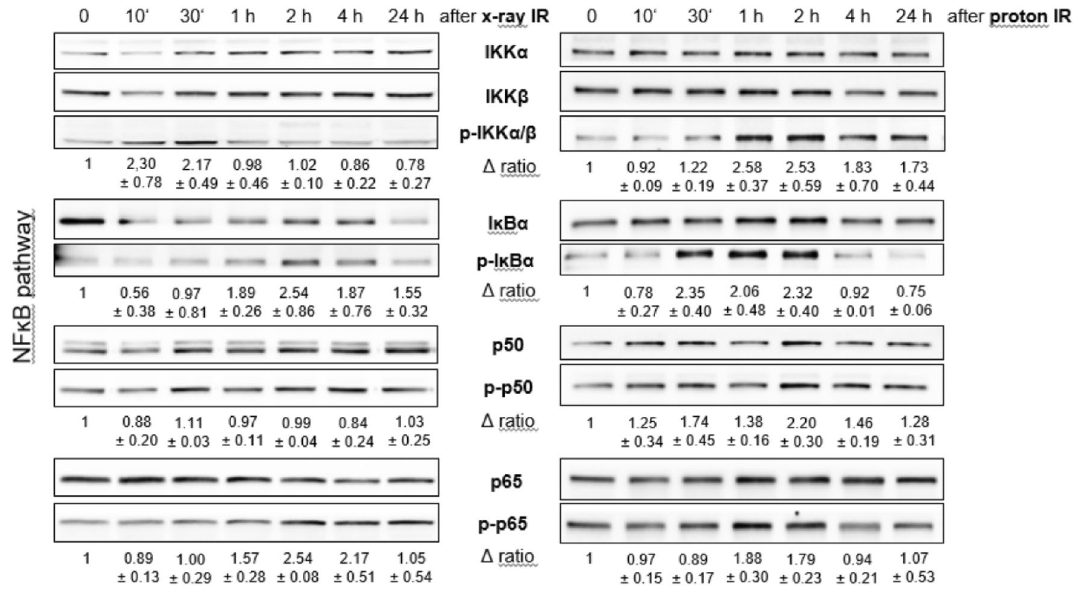
Figure 6. NF-ĸB damage pathway. Protein expression and phosphorylation of components of the NF-ĸB pathways were evaluated by immunoblotting under control conditions (0 Gy) and 10 min, 30 min, 1 h, 2 h, 4 h, and 24 h after photon (X-ray) or proton IR. β-actin was used as loading control. Δ ratio, fold change normalized to controls (mean ± SD of n = 4). Full-length blots/gels are presented in Supplementary Fig.